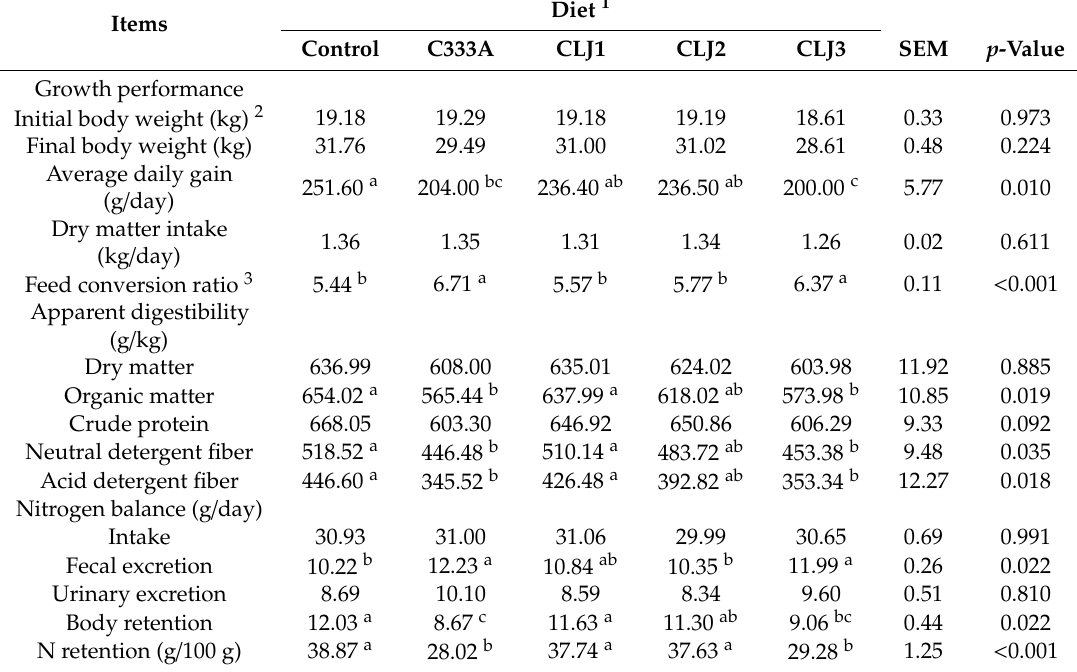
Table 3. E ff ect of dietary treatments on the growth performance, apparent digestibility, and nitrogen balance of